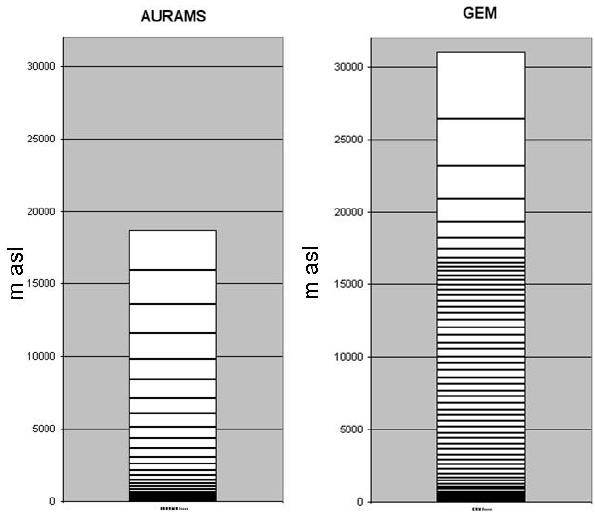
Fig. 3. Comparison of Vertical coordinate for GEM and AURAMS, plotted relative to sea-level